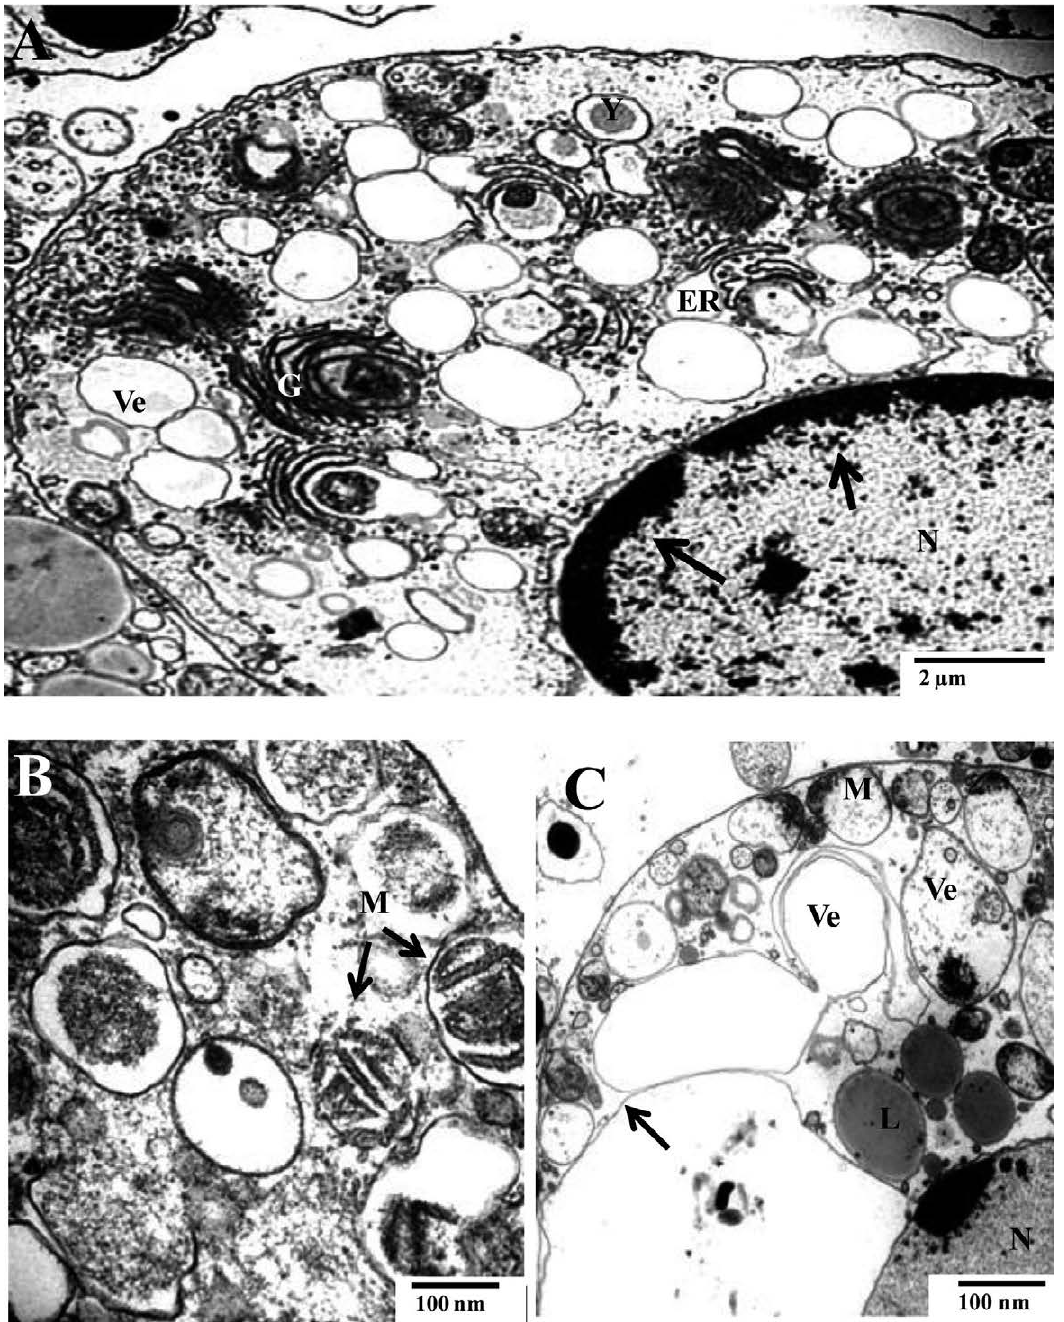
Fig. 5. – A, TEM of a previtellogenic oocyte II in diplotene stage of meiosis (arrows); note the nucleus (N) with distinct patches of hetero- chromatin under the nuclear envelope. B, scattered mitochondria (M) (arrows) with tubular cristae in the ooplams of a previtellogenic oocyte II. C, lipid droplets (L) near the nuclear envelope among distant vesicles (Ve) and mitochondria (M). ER, endoplasmic reticulum; G: Golgi complex; Y, yolk